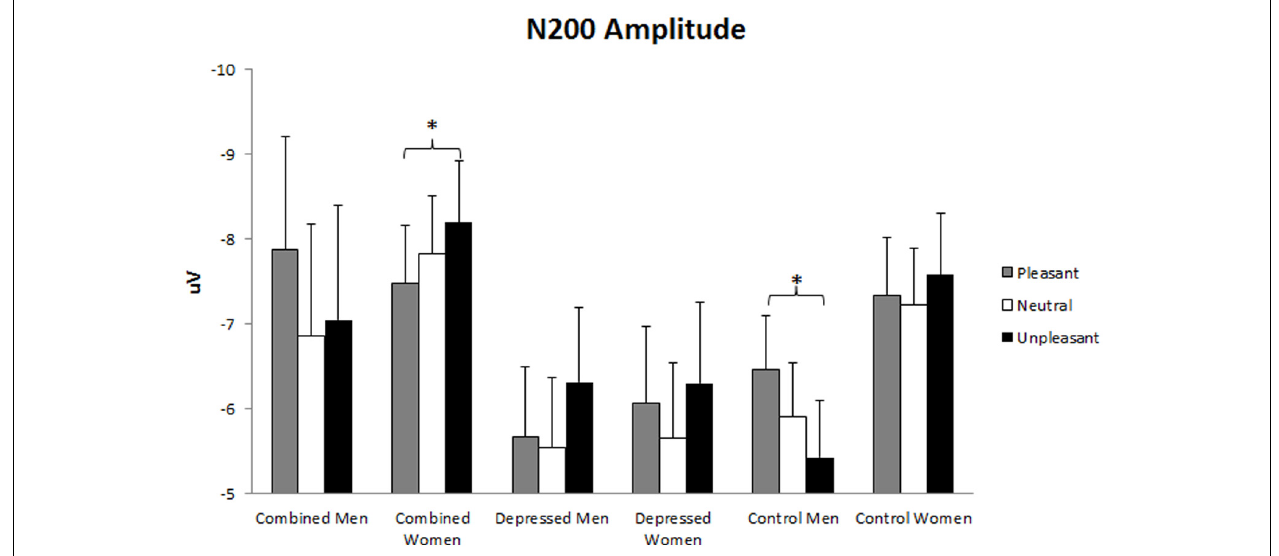
FIGURE 4 | N200 amplitude. Error bars represent 1 SE. N200 amplitude valence effect in combined women and control men.The asterisks represent significant differences with p < 0.05 in combined women (unpleasant > pleasant) and control men (pleasant > unpleasant).